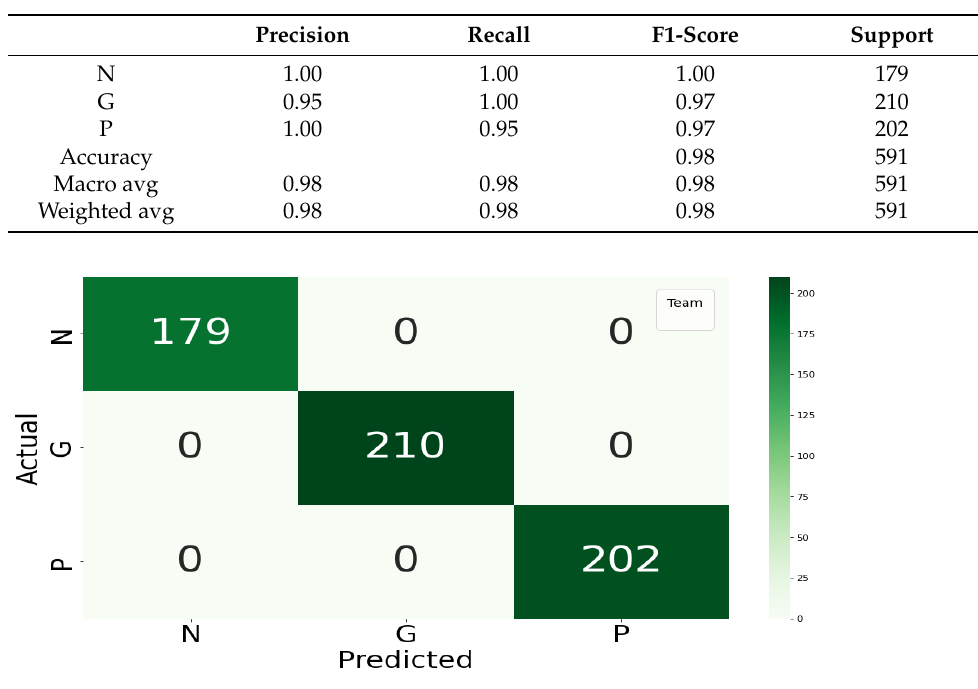
Table 4. Classification report.